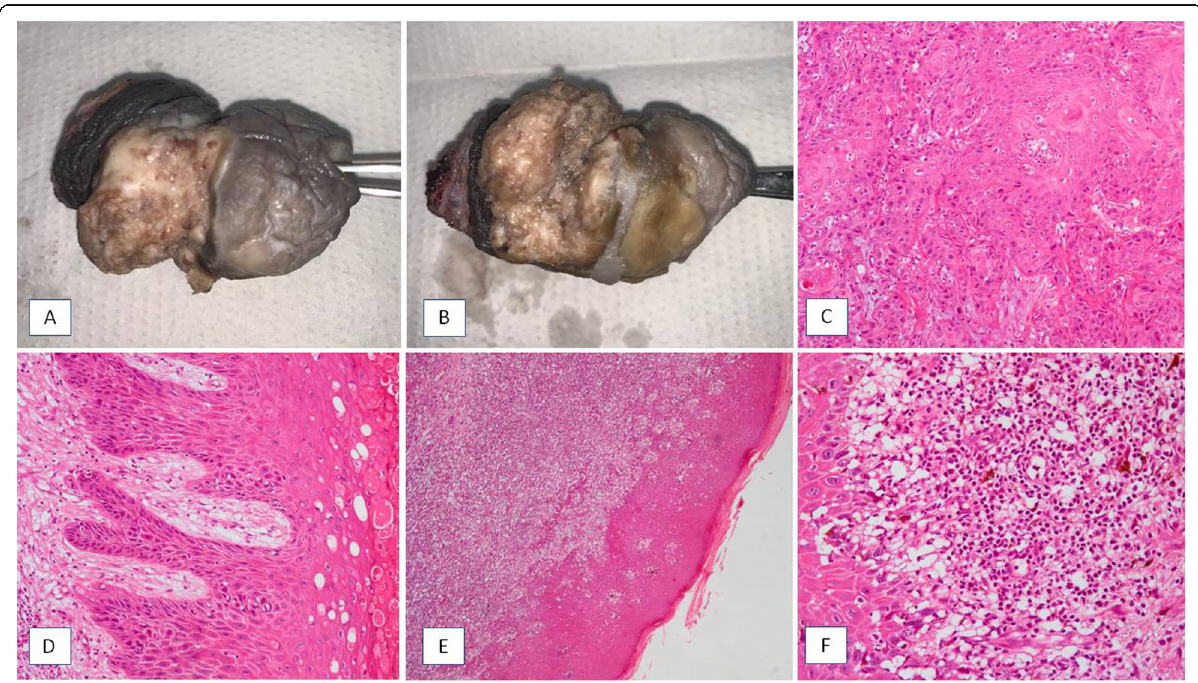
Fig. 1 a Gross specimen withexophytic tumor between foreskin and glans; b ) hyperkeratotic plaques separated from the tumor; c ) invasive usual squamous cell carcinoma (HE, 100x); d ) differentiated penile intraepithelial neoplasia (HE, 100x); e ) lichenoid inflammation (HE, 40); f ) lichenoid inflammation (HE,